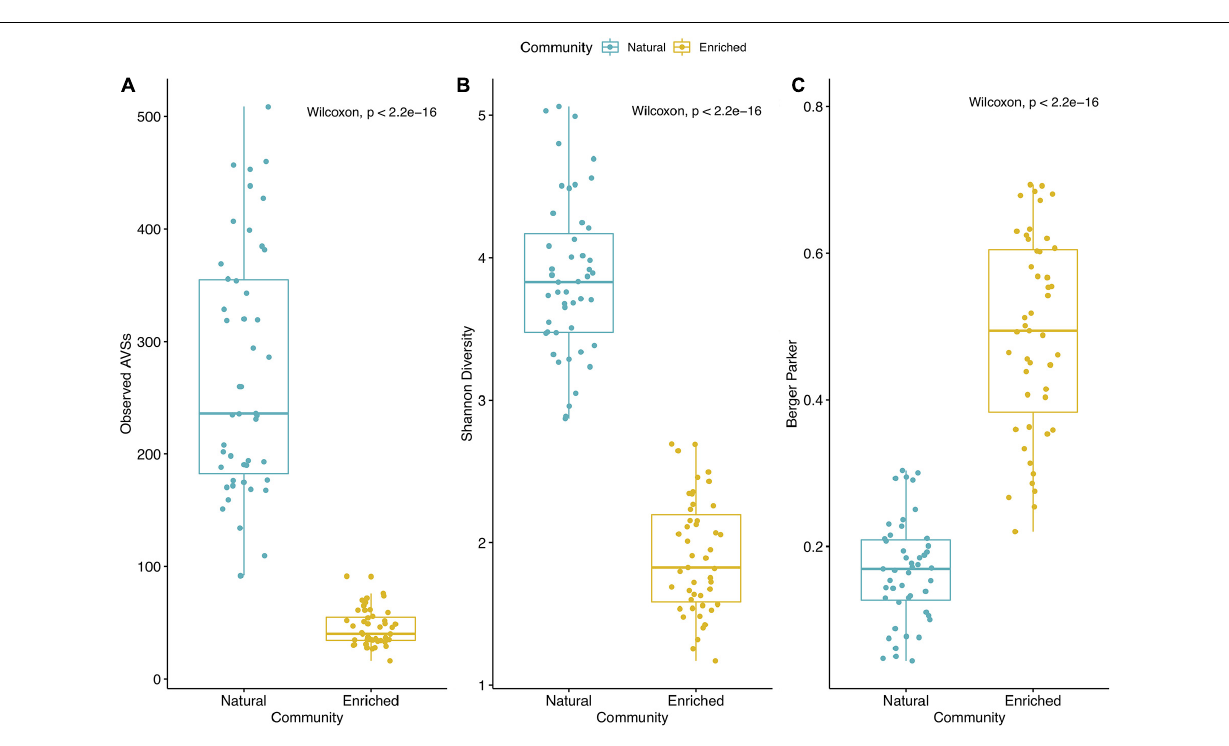
FIGURE 3 | Alpha diversity indexes for natural and enriched microbial communities. (A) Number of observed ASVs; (B) Shannon diversity index; (C) Berger parker index. Each sample is represented by one point. The boxes represent the first and third quartiles, with median value bisecting each box. The whiskers extend to the largest/smallest